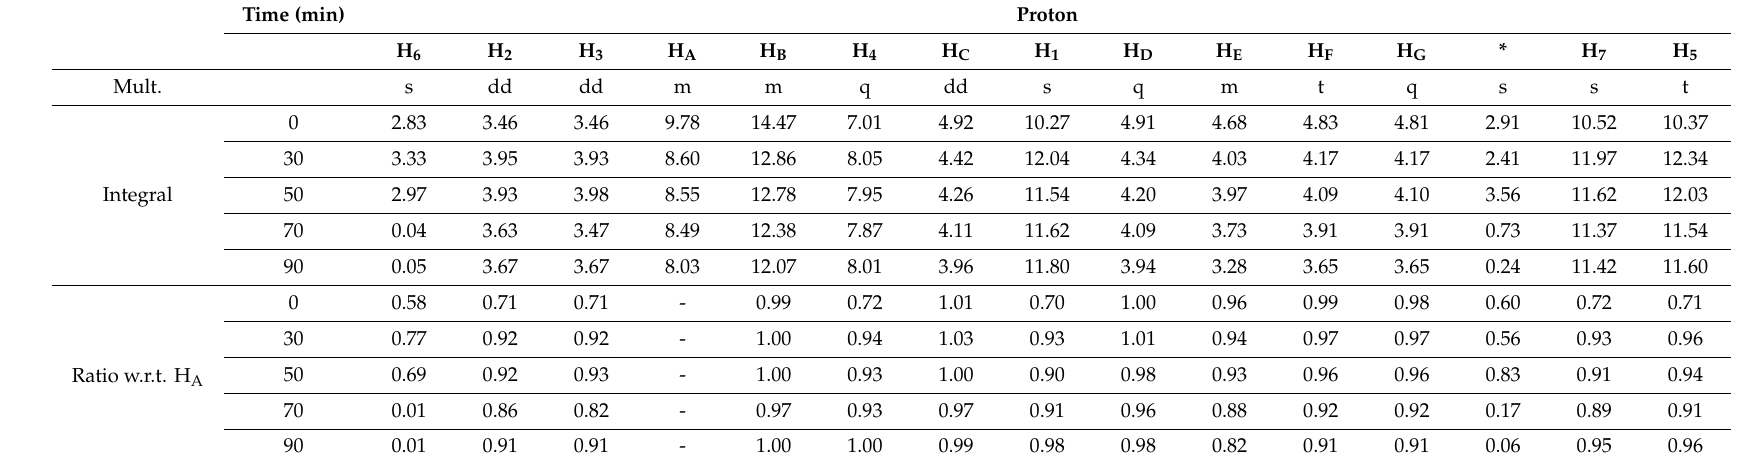
Ratio w.r.t. H A